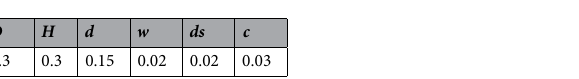
Figure 2. Different geometry configurations present in the stirred system.